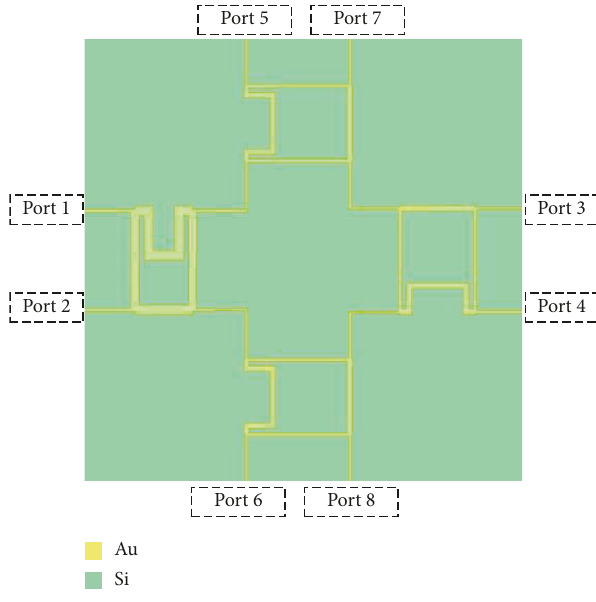
Figure 6: Butler matrix